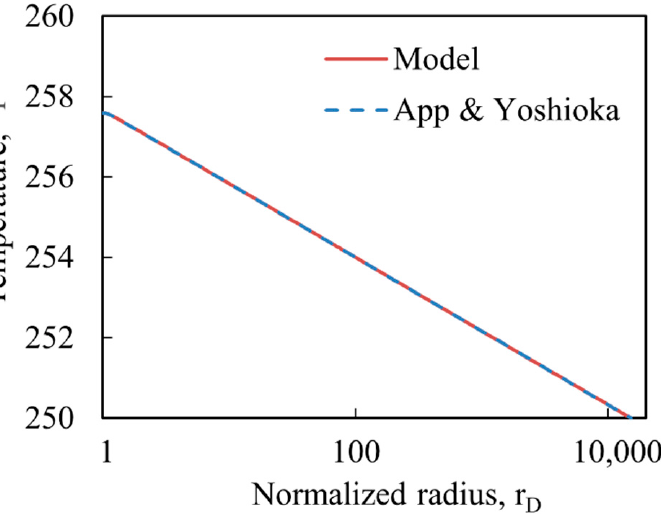
Figure 2. The comparison result of the radial temperature distribution between the two models; App and Yoshioka‘s model (blue) and our derived model (red).